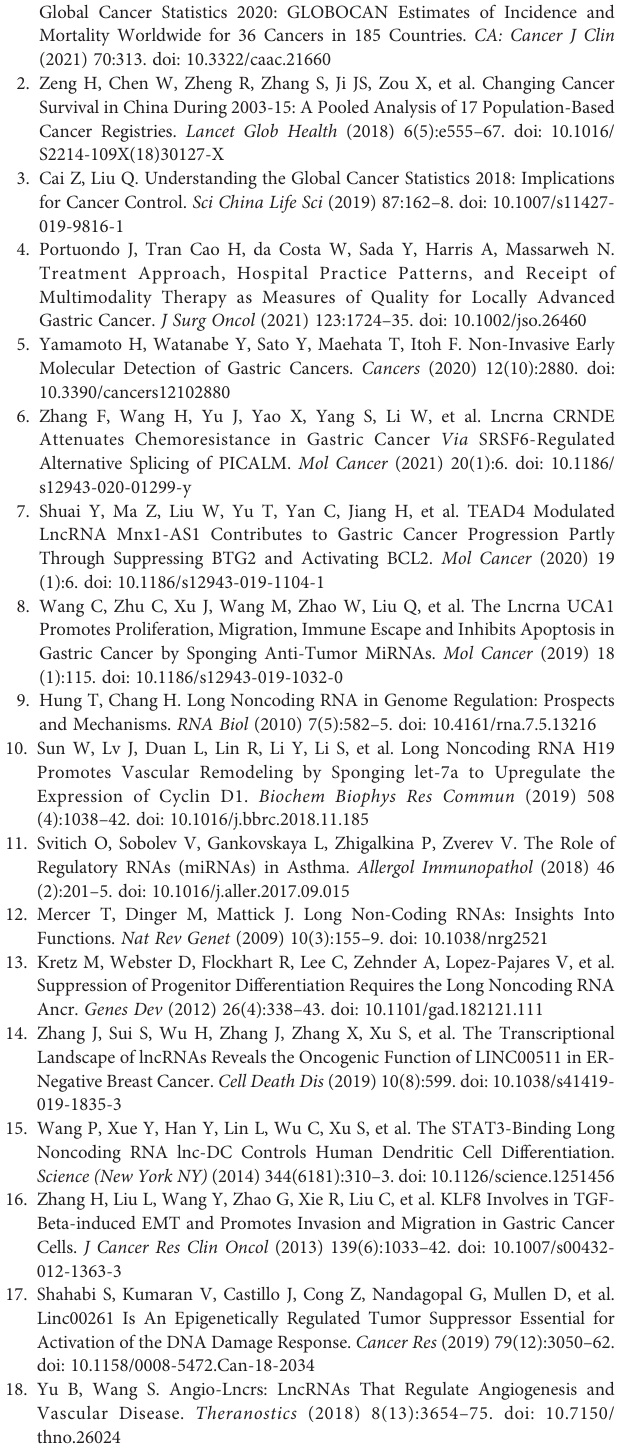
Supplementary Figure 4 | (A) The ROC curve of the TIII-TIV group. (B) The ROC curve of the TI-TII